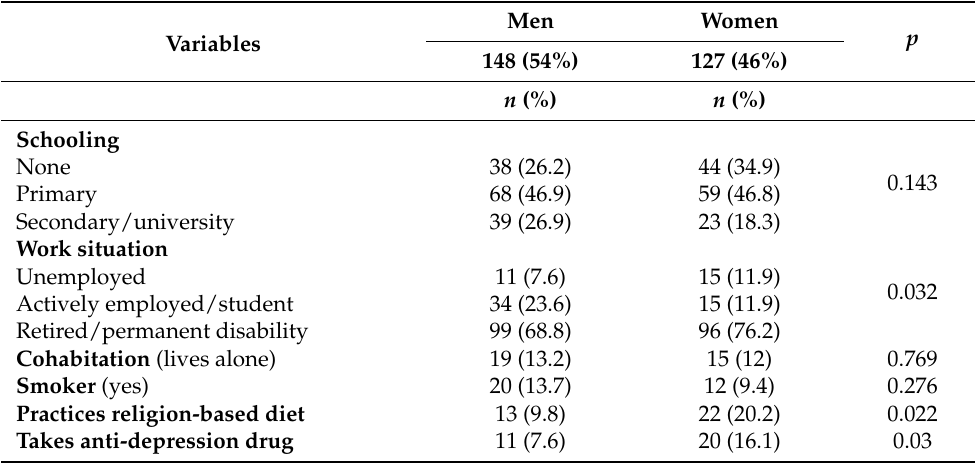
Table 2. Comparison between sexes in sociodemographic data, clinical